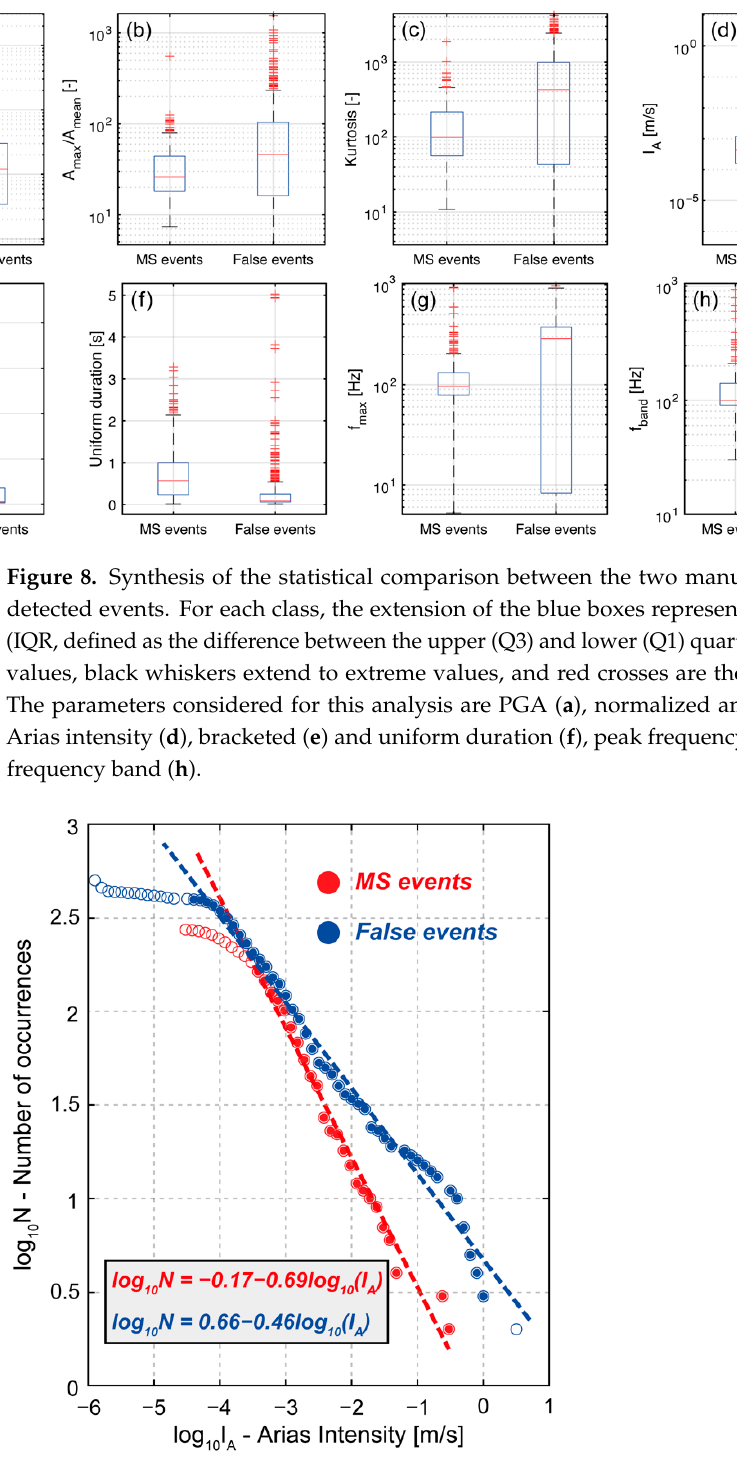
Figure 9. Comparison between the logarithm of Arias intensity (I A ) and the logarithm of the cumula- tive number of occurrences (N) for MS events and false events, following the modified Gutenberg and Richter (1954) power law